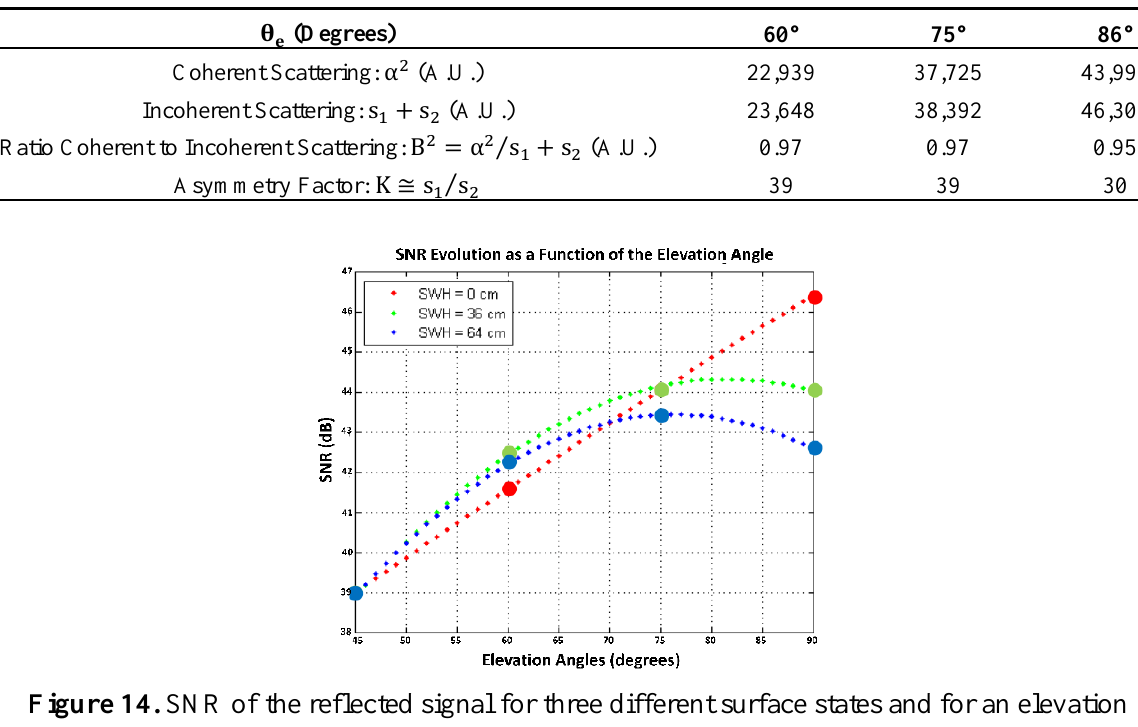
= 45° to θ = 86°. The figure was obtained using a best-fit e e